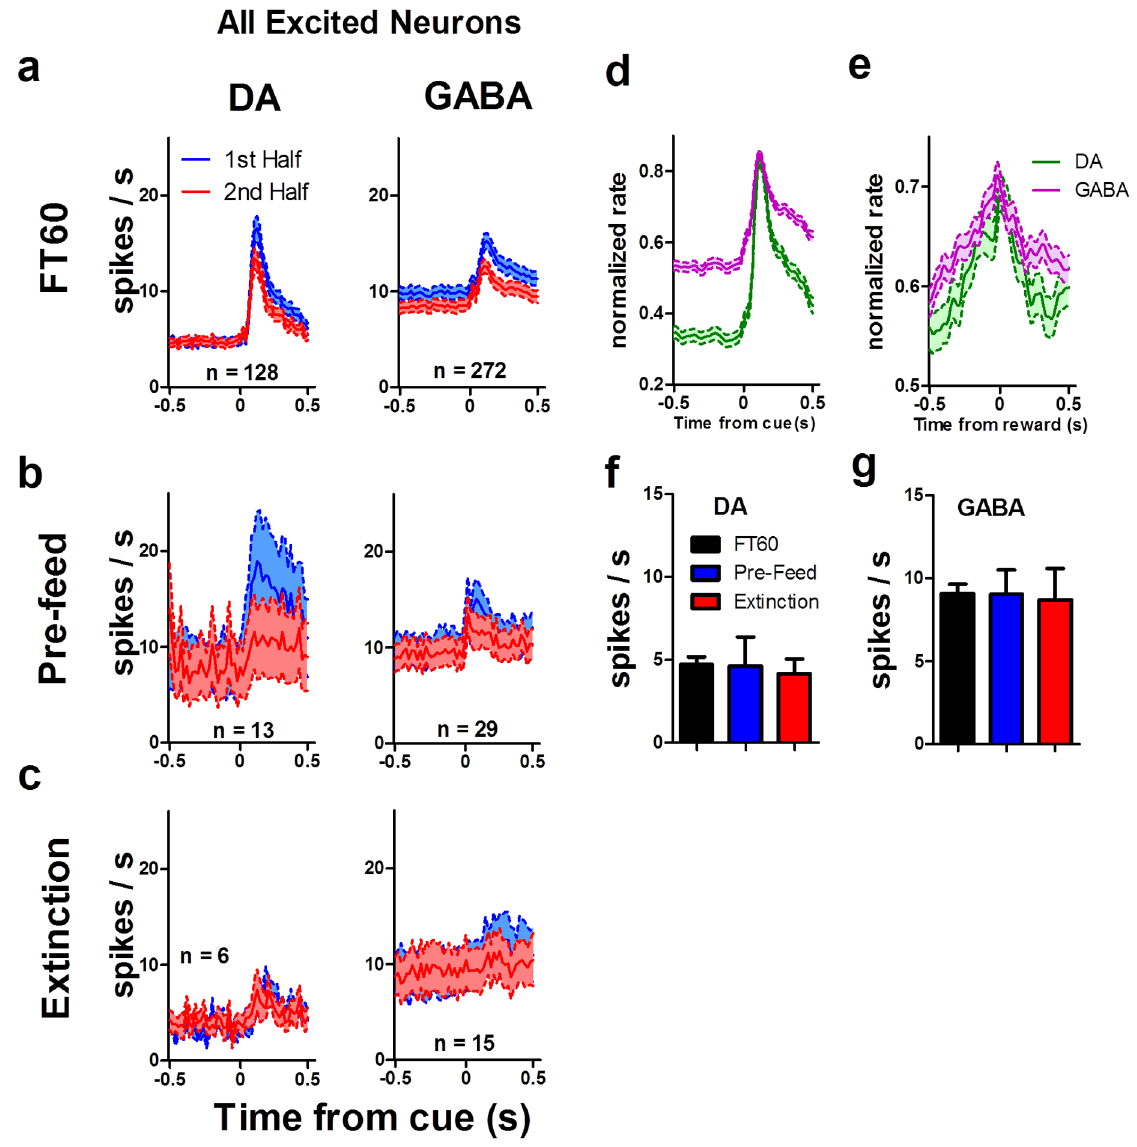
Figure 9. Average response of all excited neurons, including those that do not show motivational modulation during the session. To compare the basal activity and mean responses between the classes we examined the responses of all neurons that were excited following the cue. The activity (mean 6 s.e.m.; 20 ms bins) of all neurons with excitatory responses to the reward cue, regardless of motivational modulation, is plotted for each half of FT60 ( a ), pre-feeding ( b ) and extinction ( c ) sessions. Overall, there was a reduction in the magnitude of the phasic response as mice became sated. During extinction ( c ) the phasic response is nearly abolished for both DA and GABA neurons. The response to the cue ( d ) and to reward receipt ( e ) are dissociable. The population responses are shown for DA ( n =128) and GABA ( n =272) neurons recorded during FT60 sessions. ( f – g ) Baseline firing rates do not vary between FT60, pre-feed, or extinction sessions for DA or GABA neurons presented in a – c (one-way ANOVAs, F , 1.0, p .